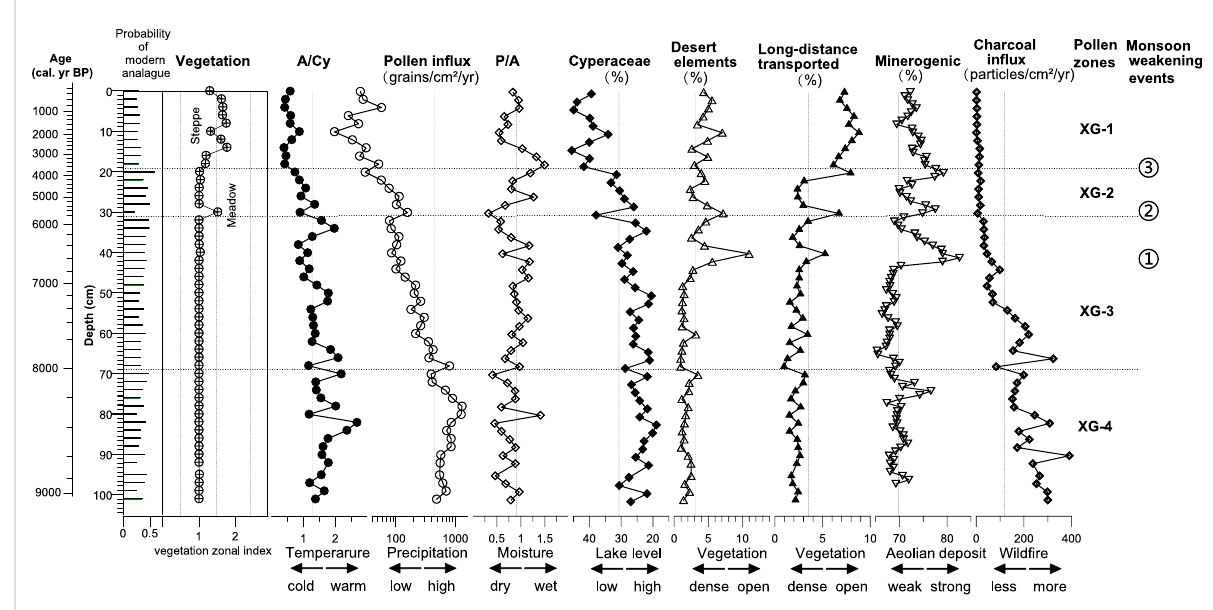
FIGURE 5 Vegetation types reconstructed by using discriminant functions of modern pollen spectra in the Tibetan Plateau, and interpretation of fossil pollen spectra from the Xuguo Co core in terms of vegetational, climatic, and environmental changes using Artemisia /Cyperaceae ratios, pollen in fl ux, Poaceae/ Artemisia ratios, Cyperaceae pollen percentage, pollen percentage of desert elements, long-distance-transported pollen percentage, minerogenic matter, and charcoal in fl ux as proxies of summer temperature, monsoonal rainfall, moisture, lake level, vegetation coverage, aeolian activity, and wild fi res, respectively. The average value of each proxy for the core is denoted by a dotted